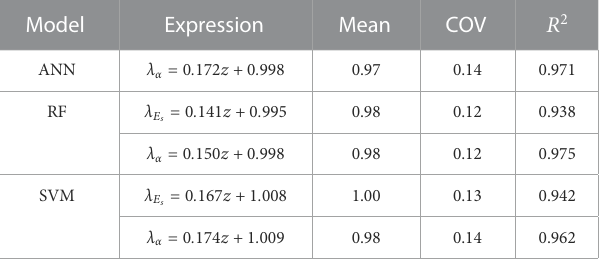
TABLE 4Expressions andbiasstatistics for the ANN, RF,andSVM models using the fi t-to-tail technique.